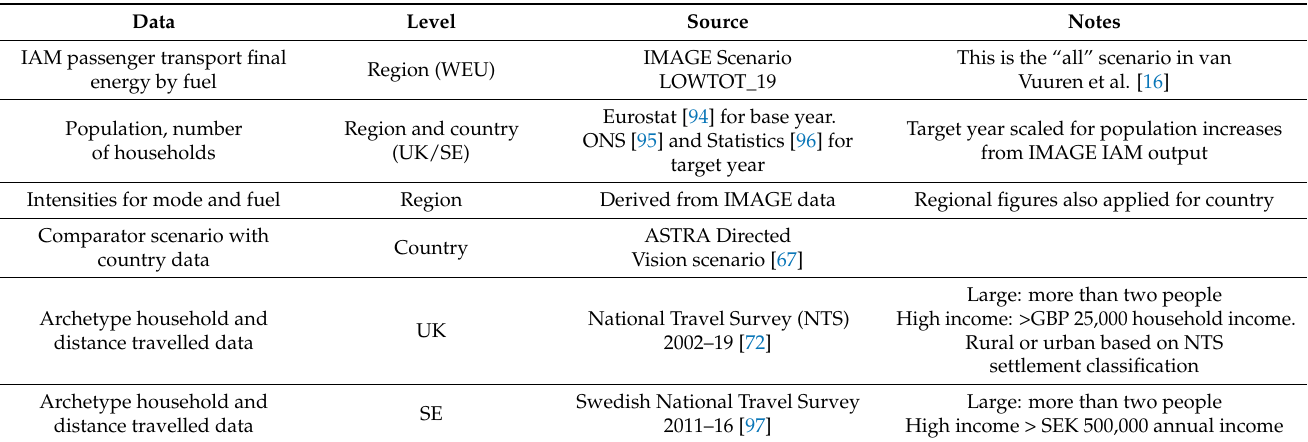
Table A2. Data sources for mobility illustration.